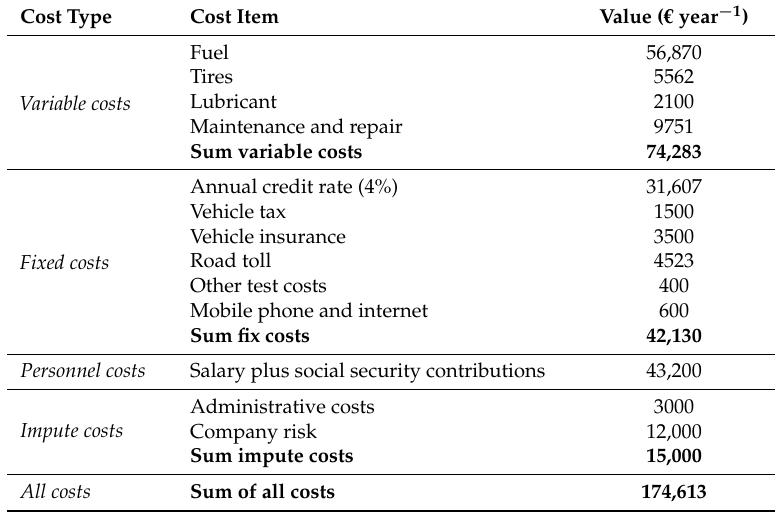
Table 2. Calculated annual expenses according to Reich et al. [26] except for fuel and labor